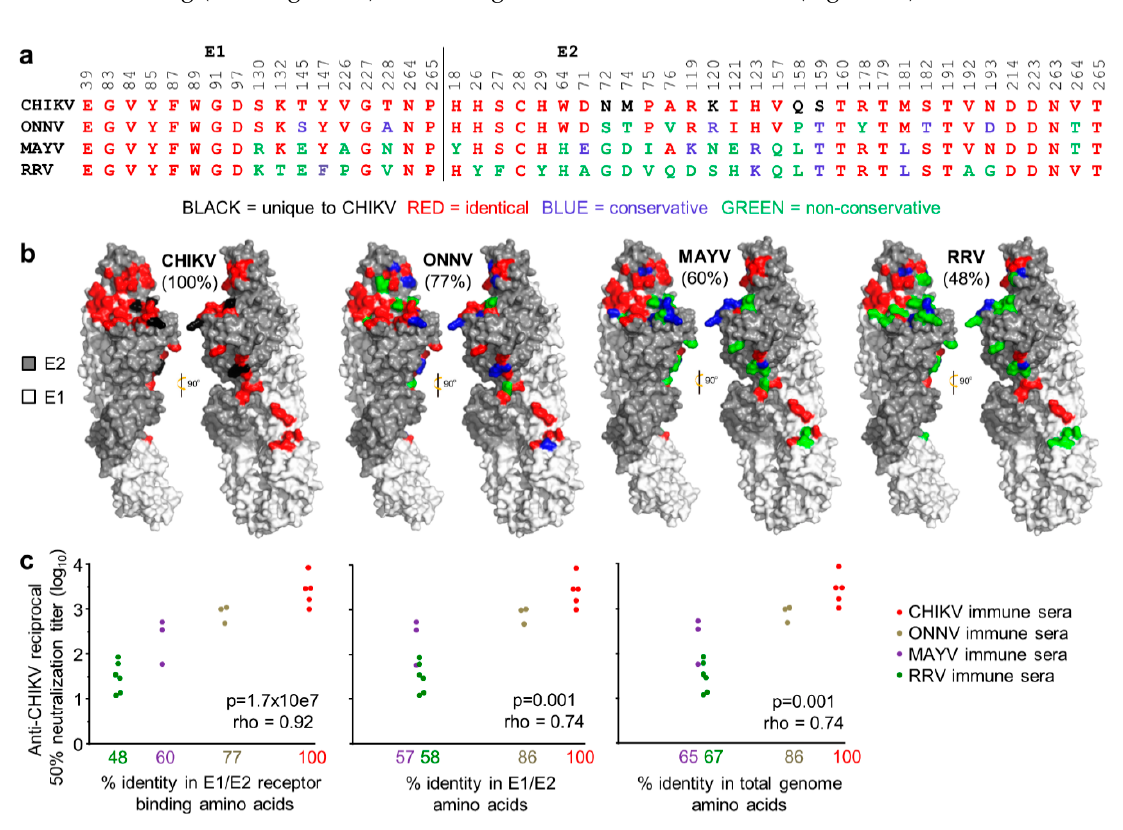
Figure 3. Conservation of receptor contact residues amongst the arthritogenic alphaviruses. ( a ) The 48 residues on the E1 / E2 Chikungunya virus (CHIKV) viral spike glycoproteins reported to make contact with the arthritogenic alphavirus receptor, MXRA8 [72] are aligned against the corresponding residues in o’nyong nyong virus (ONNV), Mayaro virus (MAYV) and RRV. Conservative and non-conservative substitutions are defined as described [86]. The complete sequence for ONNV IMTSSA 2004 was not available so residues E1 39-84 and E2 18-123 were derived from the closely related ONNV SG650 [62]; ( b ) The crystal structure of CHIKV E1 / E2, with the receptor contact residues colored as in ( a ) for each of the indicated alphaviruses. Percentages indicate the percentage of identical contact residues relative to CHIKV; ( c ) Wild-type C57BL / 6J mice were infected with CHIKV, ONNV MAYV or RRV. After 5 weeks, sera from each mouse was tested for its CHIKV neutralization titer. The neutralization titers were plotted against the % identity in E1 / E2 receptor binding amino acids (left), the % identity in E1 / E2 amino acids (middle) and % amino acid identity in the total genome (right). Statistics by Spearman’s correlations, p and rho